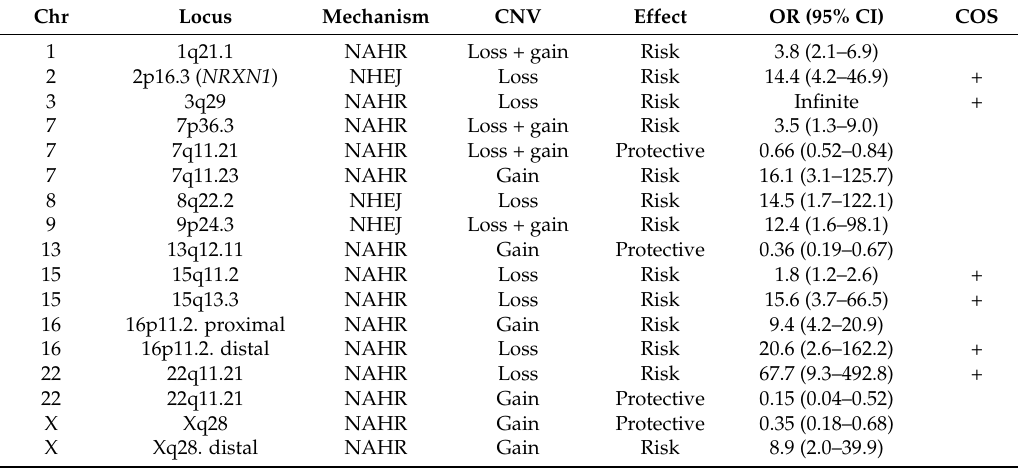
Table 1. Significant CNV loci in patients with AOS and